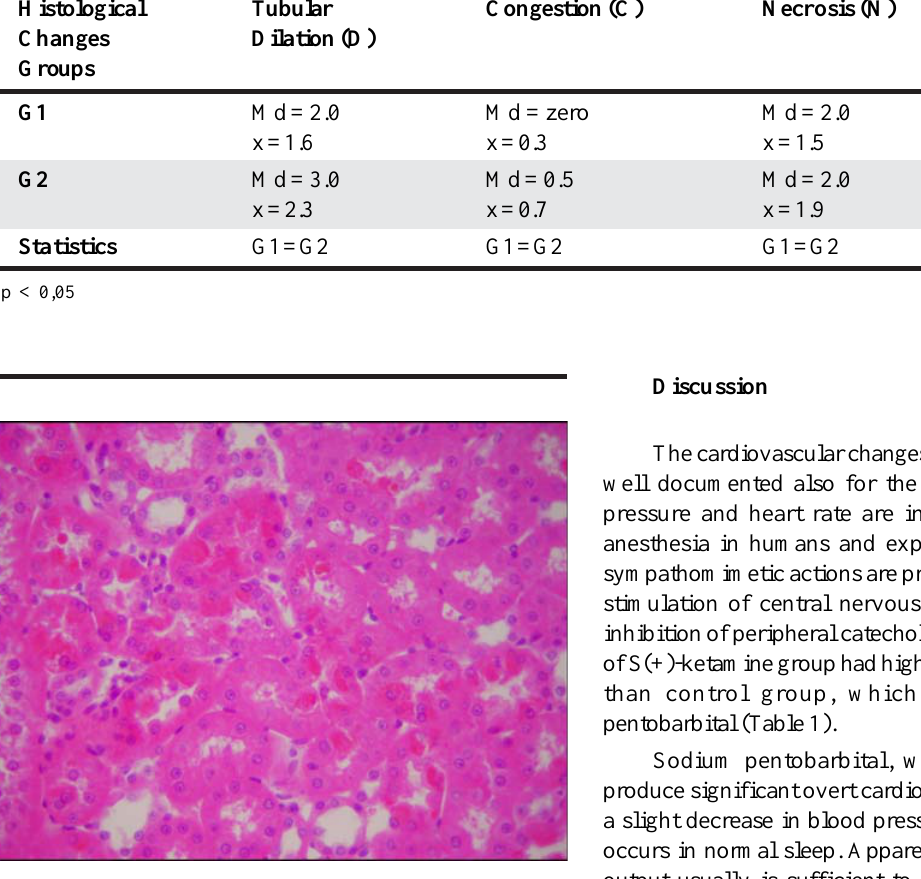
FIGURE 2 - Hemorrhage of 30% of volemia produced tubular necrosis in the kidney rat. G1 =